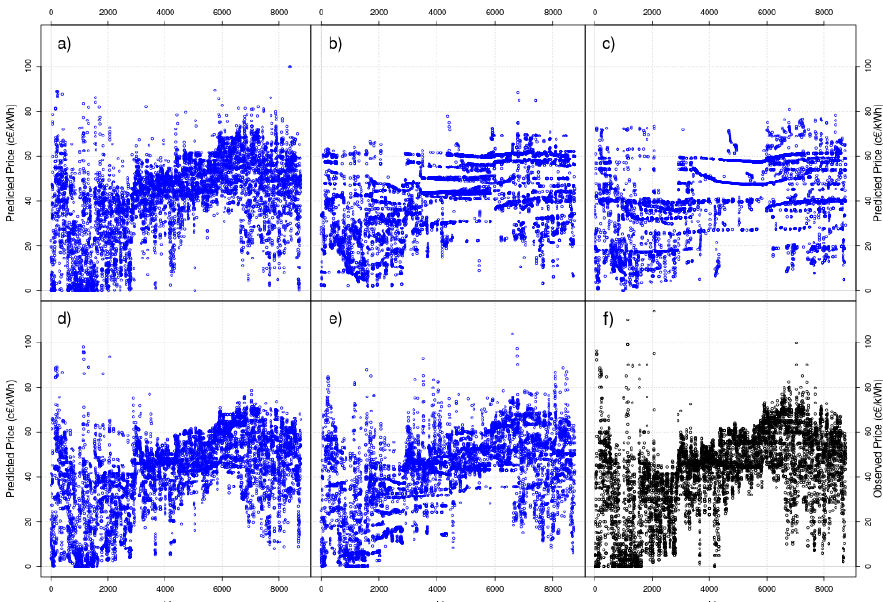
Figure 3. As blue points, one-hour ahead forecasts of DT with constant mean for a moving window of 50 days. ( a ) Full model, ( b ) retire the oldest data, ( c ) retire the data discarded by active learning, ( d ) retire the oldest data and rejuvenate the particle set and ( e ) retire the data discarded by active learning and rejuvenate the particle set. As black points, ( f ) the 2014 real data to forecast.